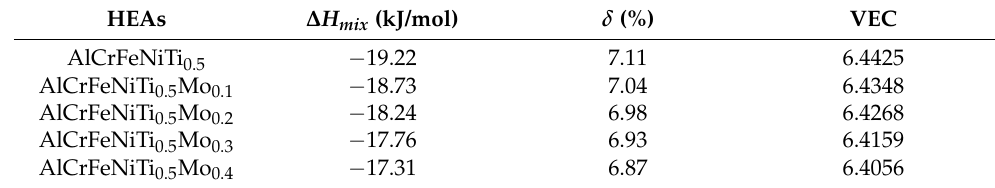
Table 6. Calculated parameters for AlCrFeNiTi 0.5 Mo x (x = 0, 0.1, 0.2, 0.3 and 0.4) HEAs. HEAs ∆ H mix